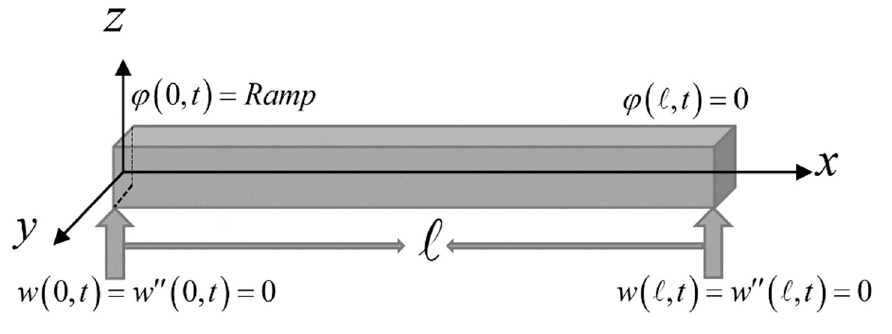
Figure 1. Rectangular thermoelastic nanobeam.